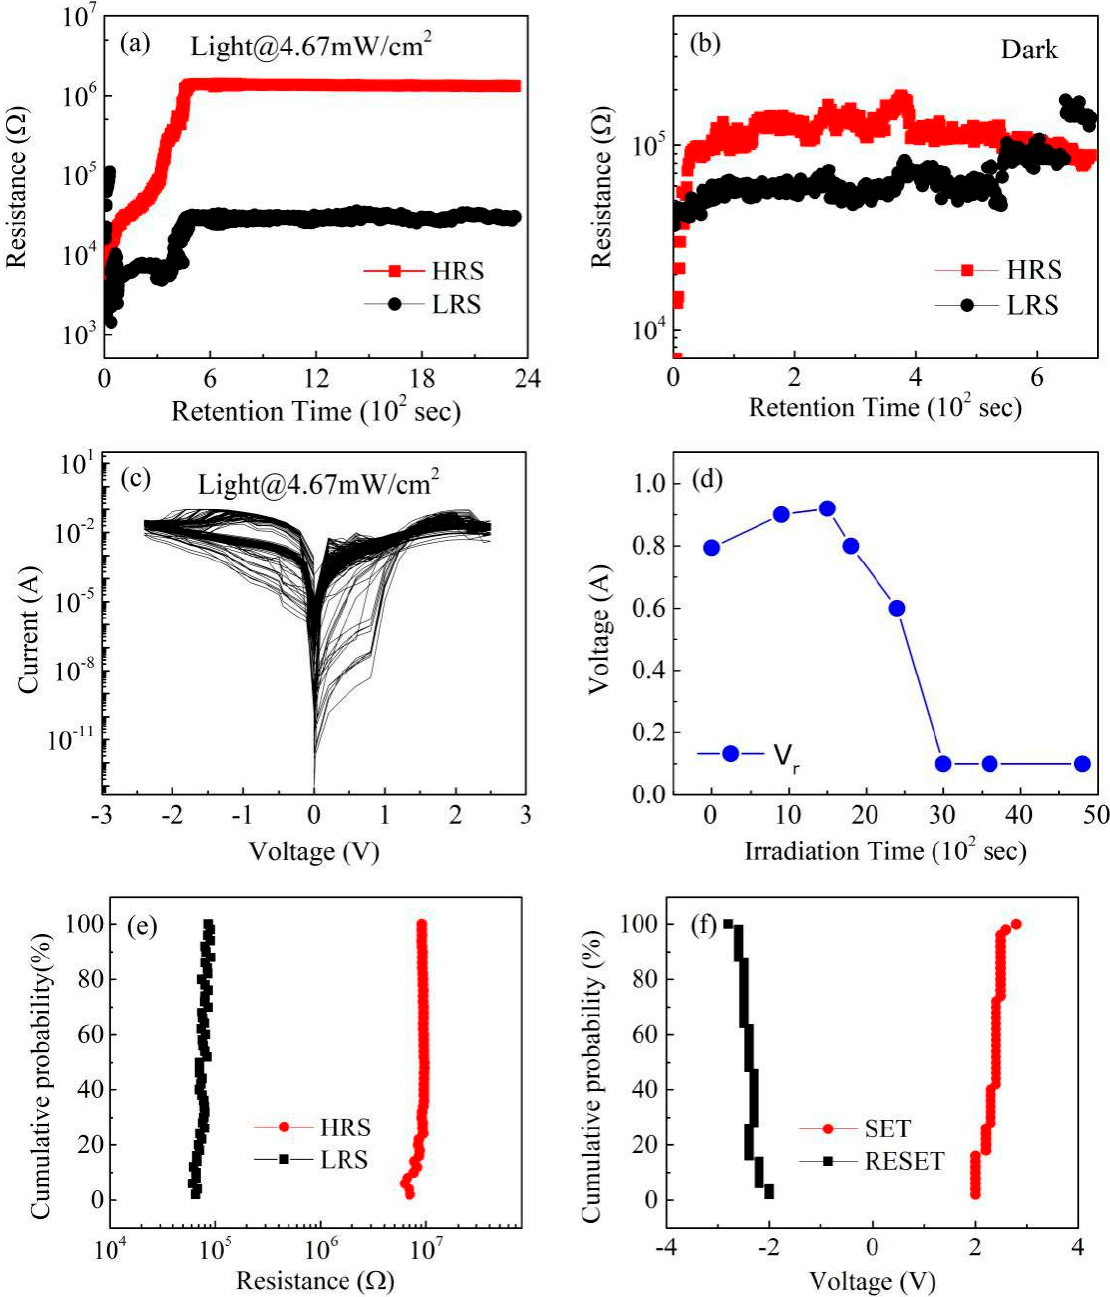
Figure 3. Resistance vs. time measured at 0.1 V after poling by +2 and − 2 V under violet–light irradiation ( a ) and in dark conditions ( b ). ( c ) I – V sweeps of the Pt/CABB/ITO/glass device for 500 cycles under light illumination. ( d ) The relationship of V r and exposure time tested under the light irradiation of 445 nm wavelength. ( e ) Cumulative resistance distribution of HRS and LRS extracted from 100 cycles in the Pt/CABB/ITO/glass device. ( f ) The distributions of the SET and RESET